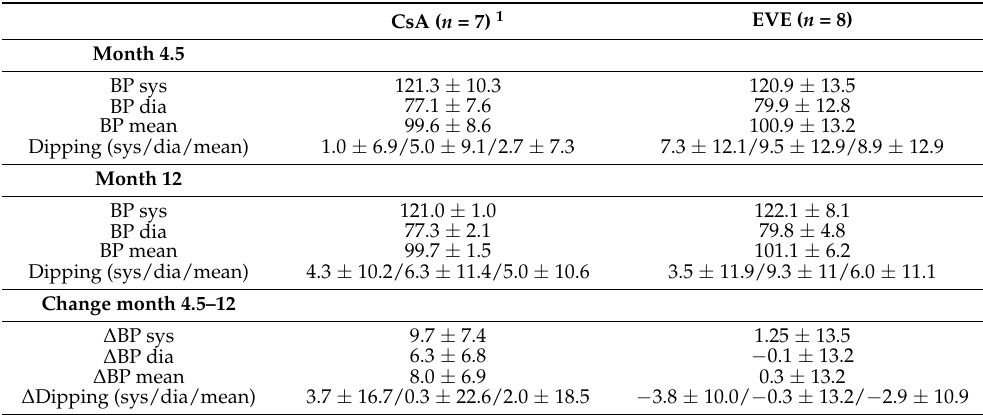
Table 7. Mean ABPM-derived blood pressure profile according to medication group and